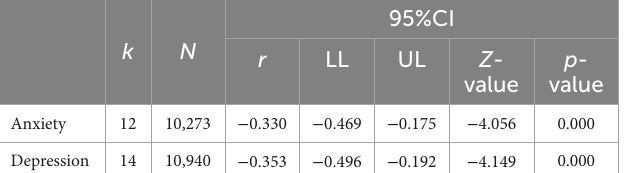
TABLE 3 Overall